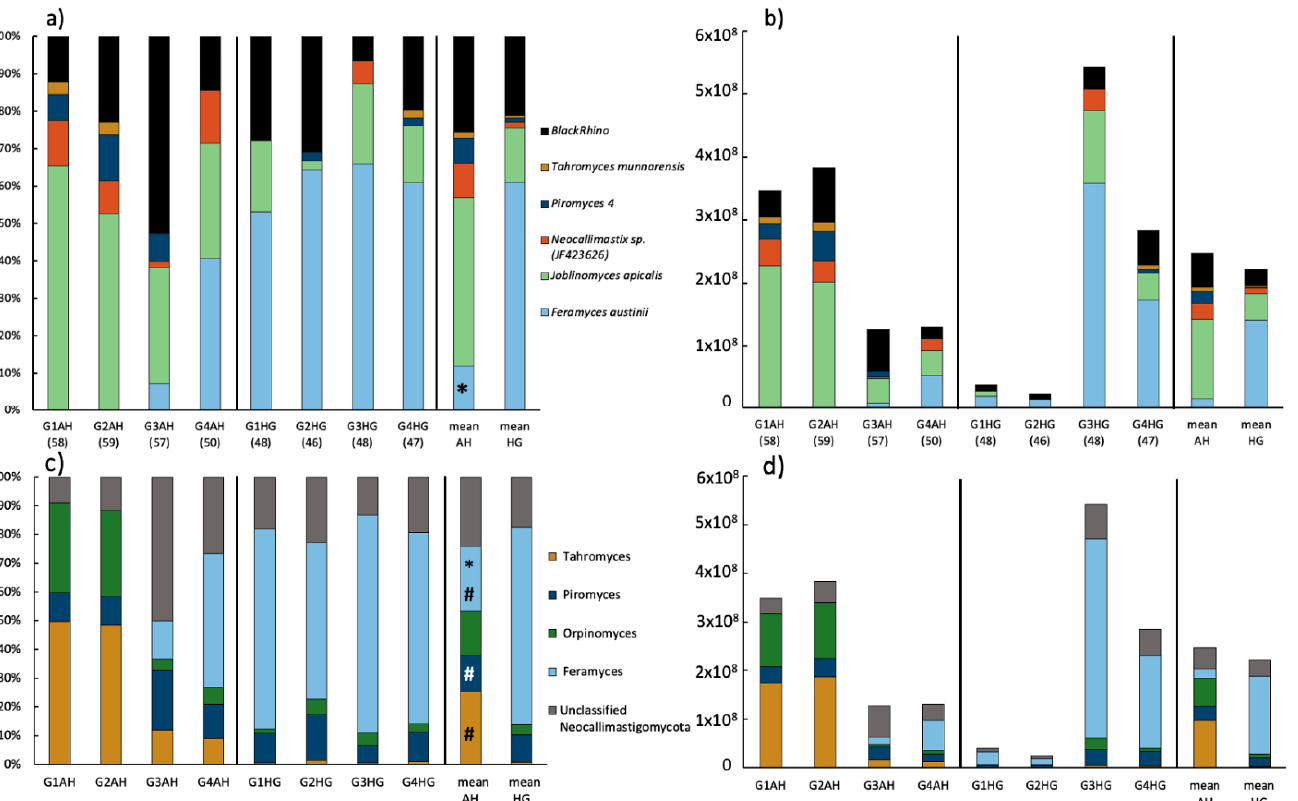
Figure 4. Neocallimastigomycota community composition of rumen samples of goats fed either AH or HG and mean values of both treatments: ( a ) relative and ( b ) absolute abundance of anaerobic fungi as detected by ITS1 clone library approach. The number of analyzed clones is given in brackets. ( c ) Relative and ( d ) absolute abundance of anaerobic fungi as detected by amplicon sequencing of the ITS2 region. Absolute abundance is based on qPCR results. Significant changes between treatments are indicated by an asterisk (t-test on relative genus-abundance data) or hash (based on DESeq2 analysis of ASV raw data).